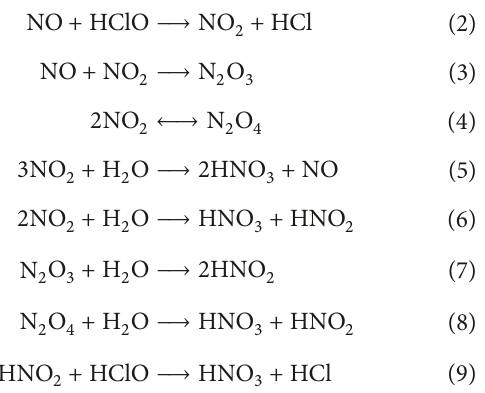
Figure 2: Effect of initial solution pH on NO (gas flow is 1.25 L/min, inlet NO concentration is 0.0125–0.1M, and solution temperature is 293 K).